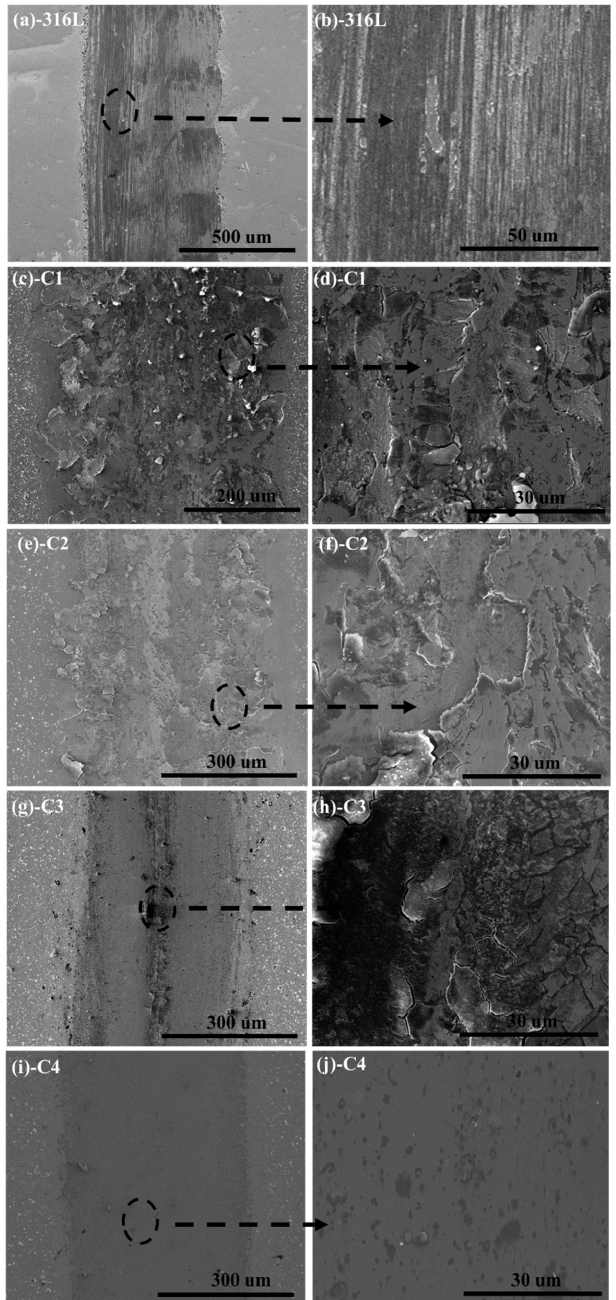
Figure 9. The morphologies of wear track on 316L substrate and CrN films: ( a , b ) 316L; ( c , d ) C1; ( e , f ) C2; ( g , h ) C3; ( i , j ) C4.